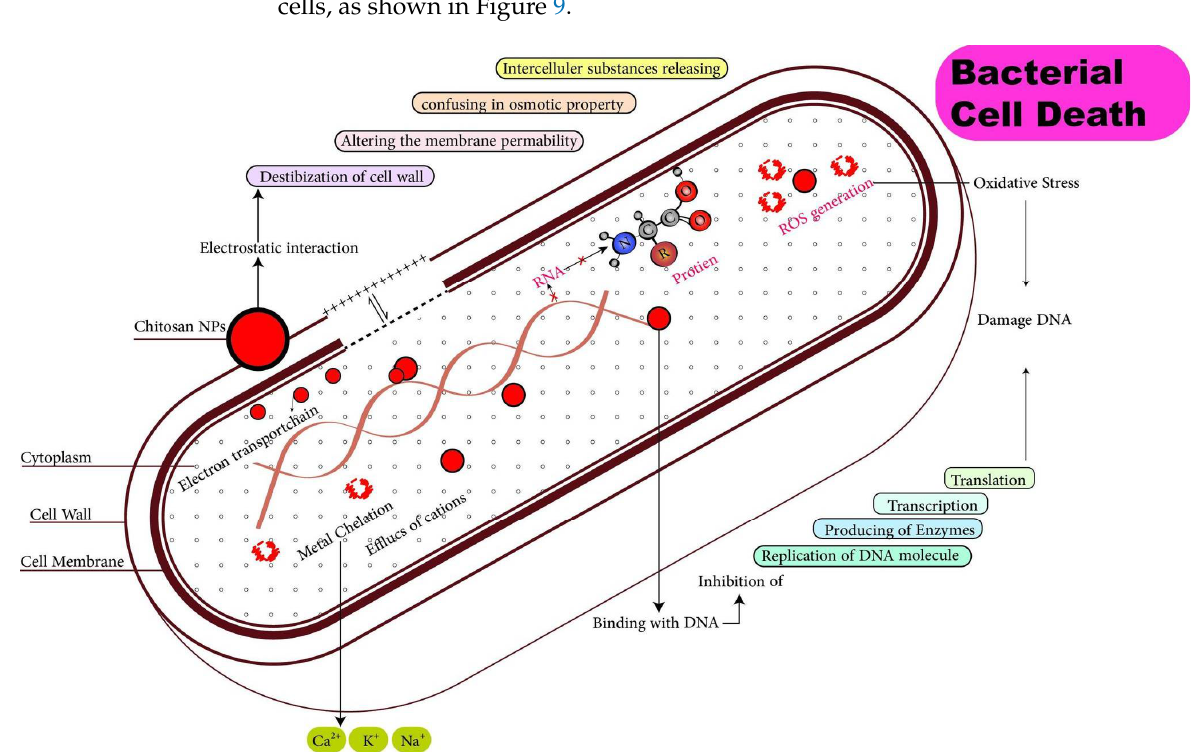
Figure 9. Antibacterial mechanism of chitosan nanoparticles.